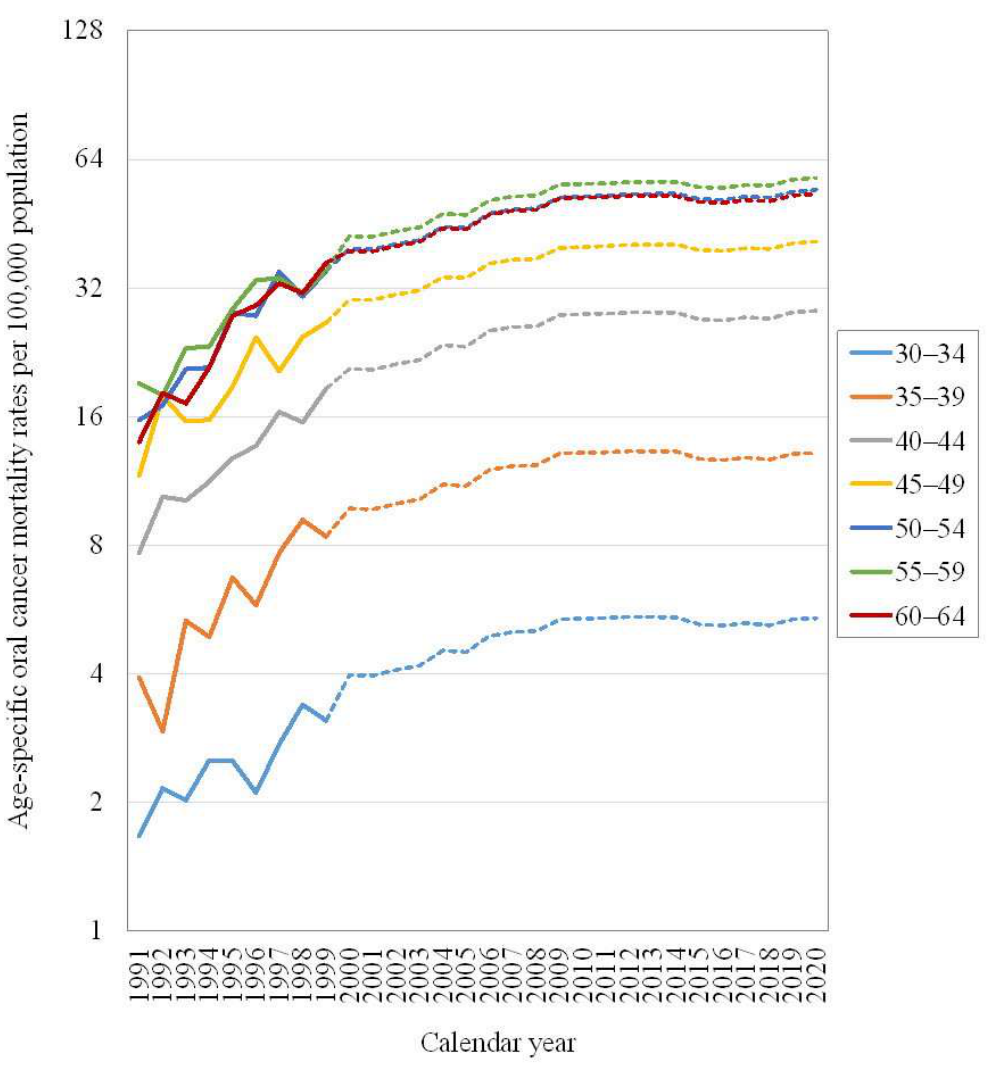
Figure 2. The observed (from 1991 to 1999) and expected (with no screening program in 2000–2020) age-specific mortality rates of oral cancer in men aged 30 to 64 in Taiwan.